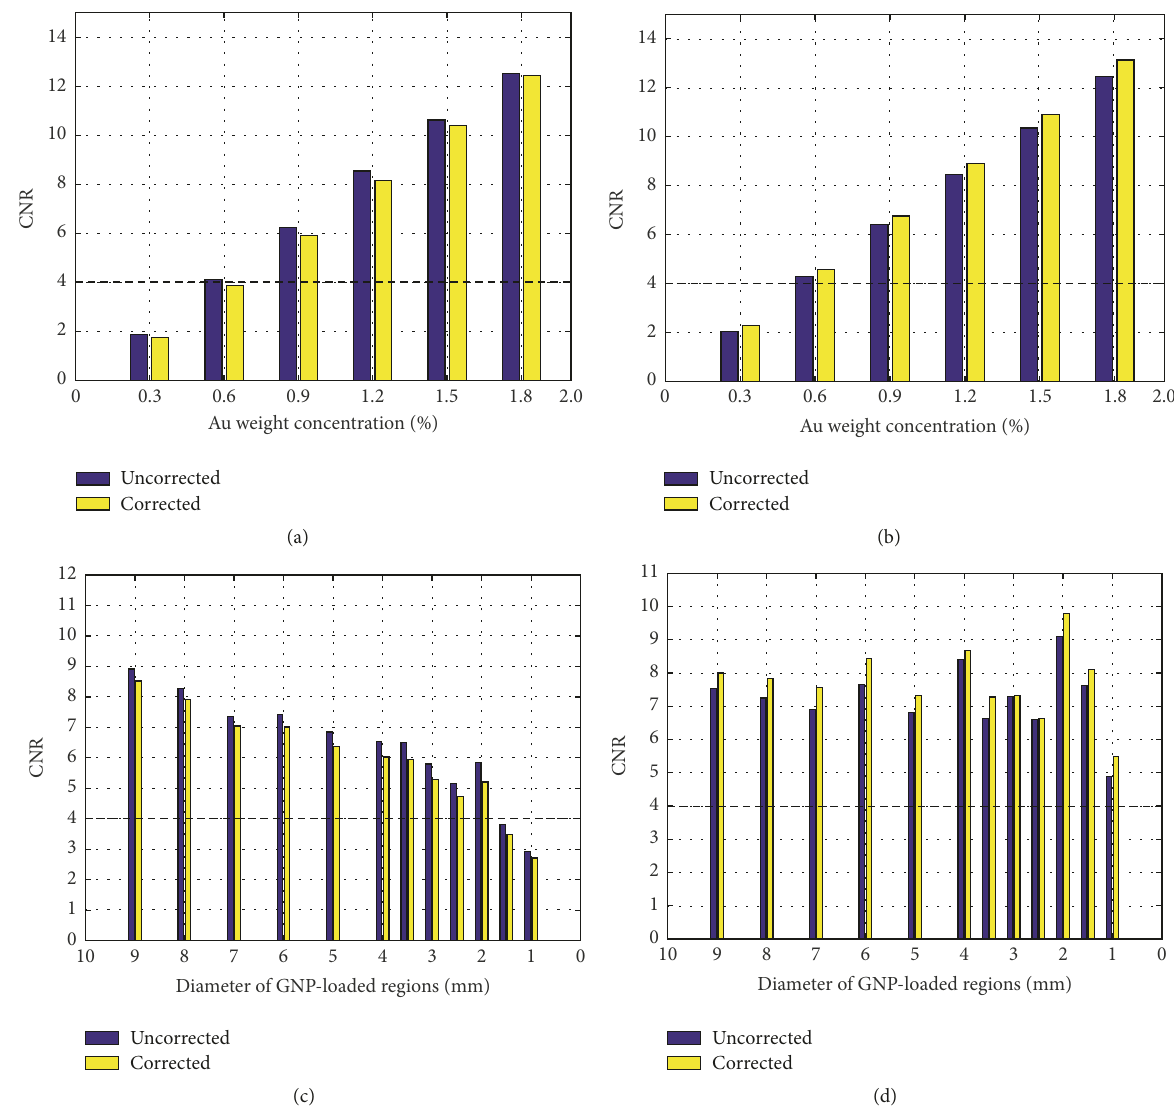
Figure 11: CNR. (a) and (c) Acquired by FBP algorithm with and without correction. (b) and (d) Acquired by MLEM algorithm with and without